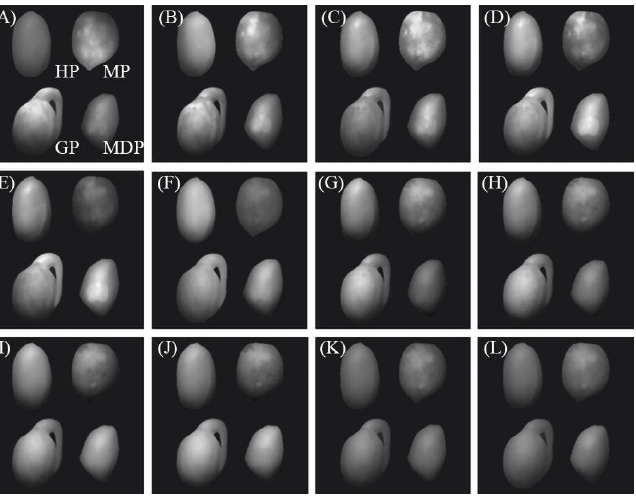
Figure 1. Grayscale images of peanuts under illumination of different wavelengths: ( A ) 365 nm , ( B ) 377 nm , ( C ) 440 nm , ( D ) 470 nm , ( E ) 520 nm , ( F ) 594 nm , ( G ) 652 nm , ( H ) 698 nm , ( I ) 766 nm , ( J ) 801 nm , ( K ) 901 nm , ( L ) 975 nm .